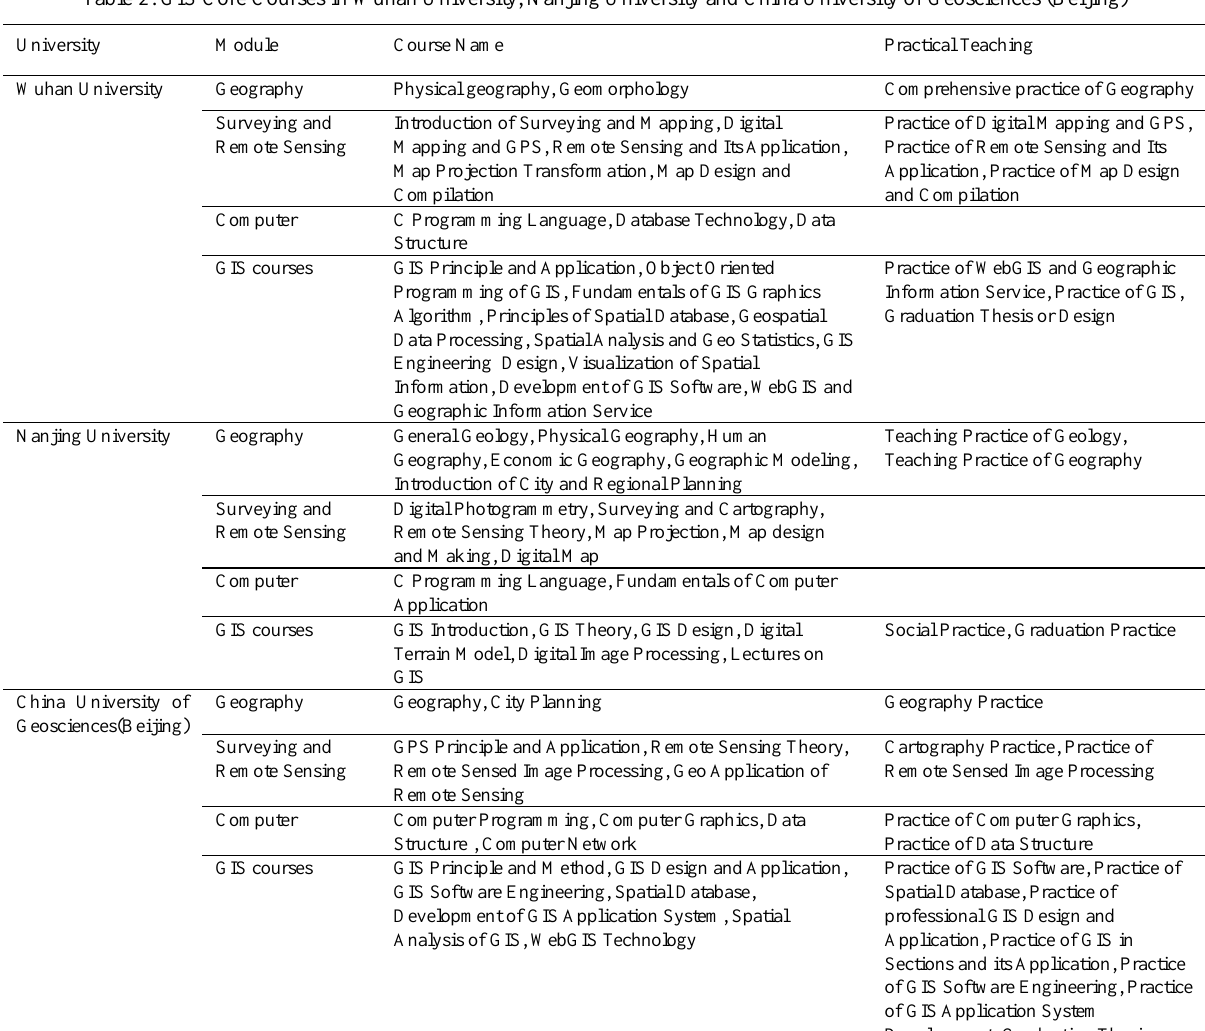
Table 2. GIS Core Courses in Wuhan University, Nanjing University and China University of Geosciences (Beijing)